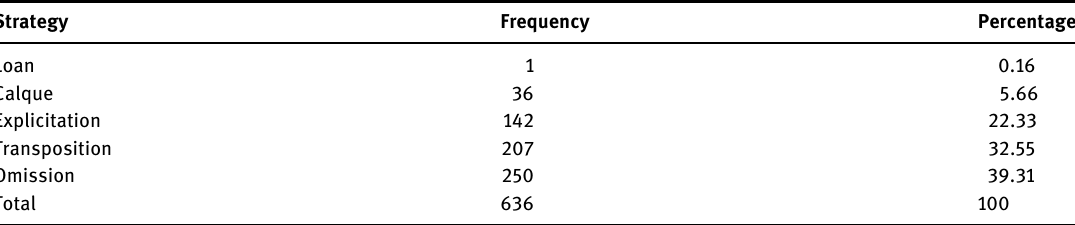
Table 6: Swearing and translation